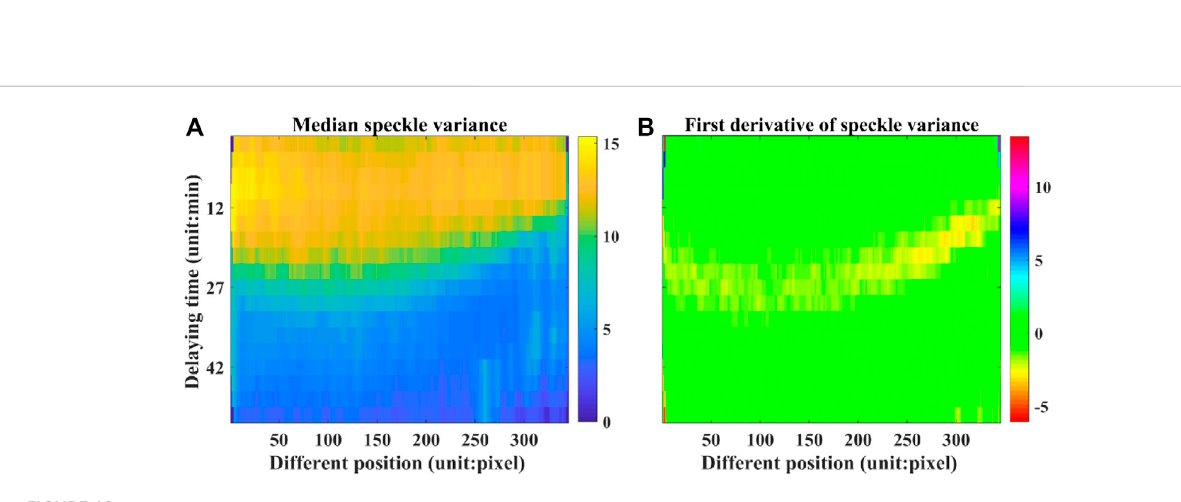
FIGURE 10 (A) Pixel-wise speckle variance map and (B) corresponding fi rst derivative of whole blood during coagulation and drying